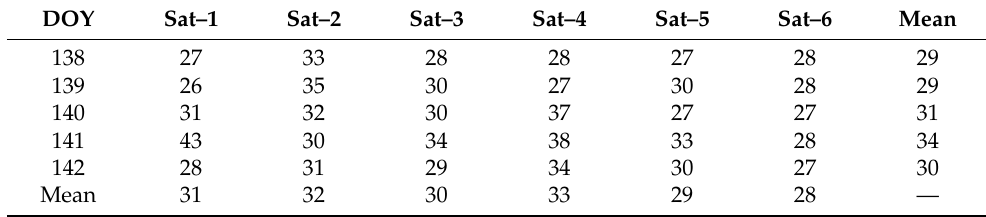
Table 2. Utilization of GPS observations of COSMIC-2, DOY 138–142, 2021